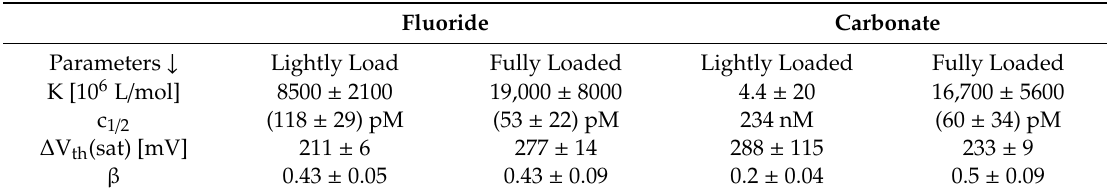
Figure 10. For comparison, parameters for fully La-loaded resin are also shown (taken from Tables 1 and 2).